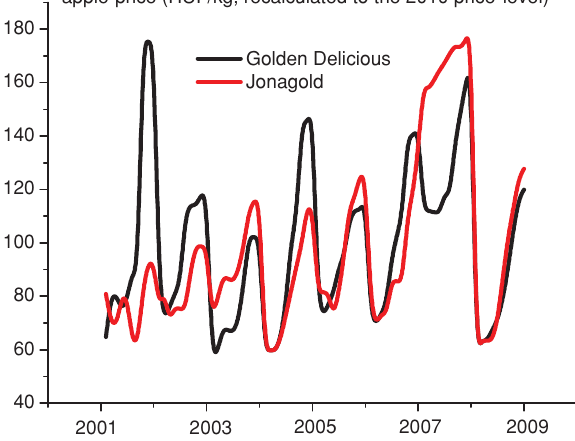
Figure2. The time series of producer prices of two important apple-varieties in Hungary